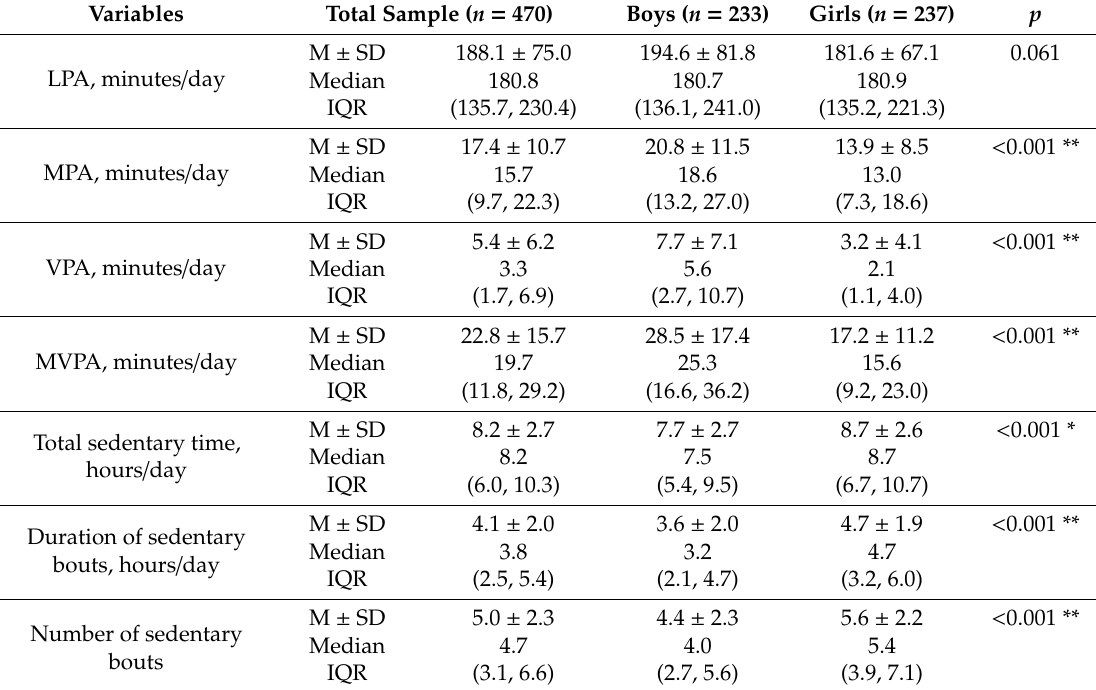
Table 2. Time spent in objectively measured PA and SB patterns in adolescents in a 7-day period.